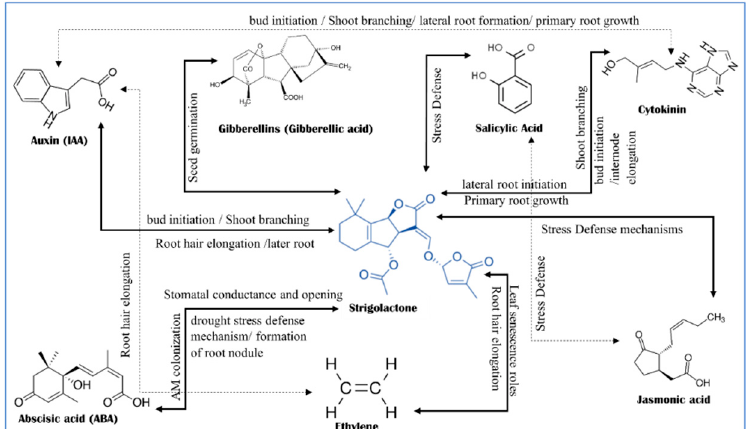
Figure 4. The crosstalk between Strigolactones and other phytohormones and the consequences of growth development. Many physiological and morphological changes occurred as a result of the communications between SLs and other phytohormones.